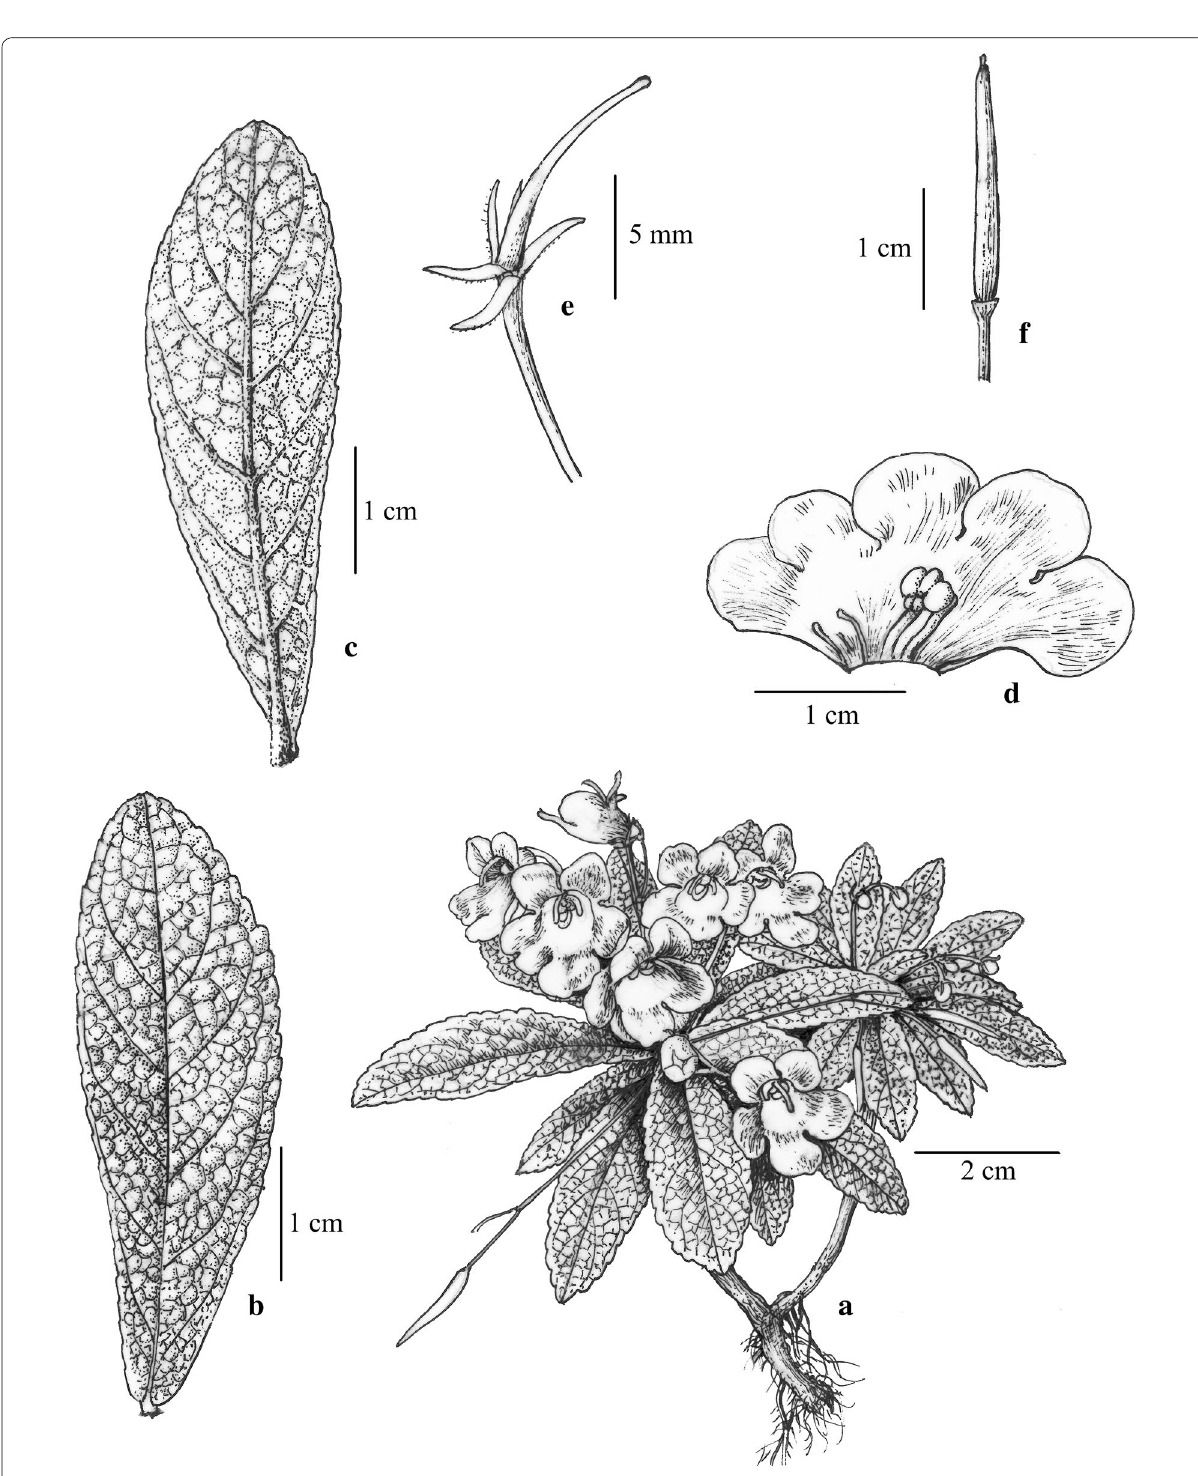
Fig. 2 Paraboea dushanensis W.B.Xu & M.Q.Han. a Habit; b upper surface of leaf; c lower surface of leaf; d opened corolla showing stamens and staminodes. e Pistil and calyx; f capsule (Drawn by W.H. Lin from the